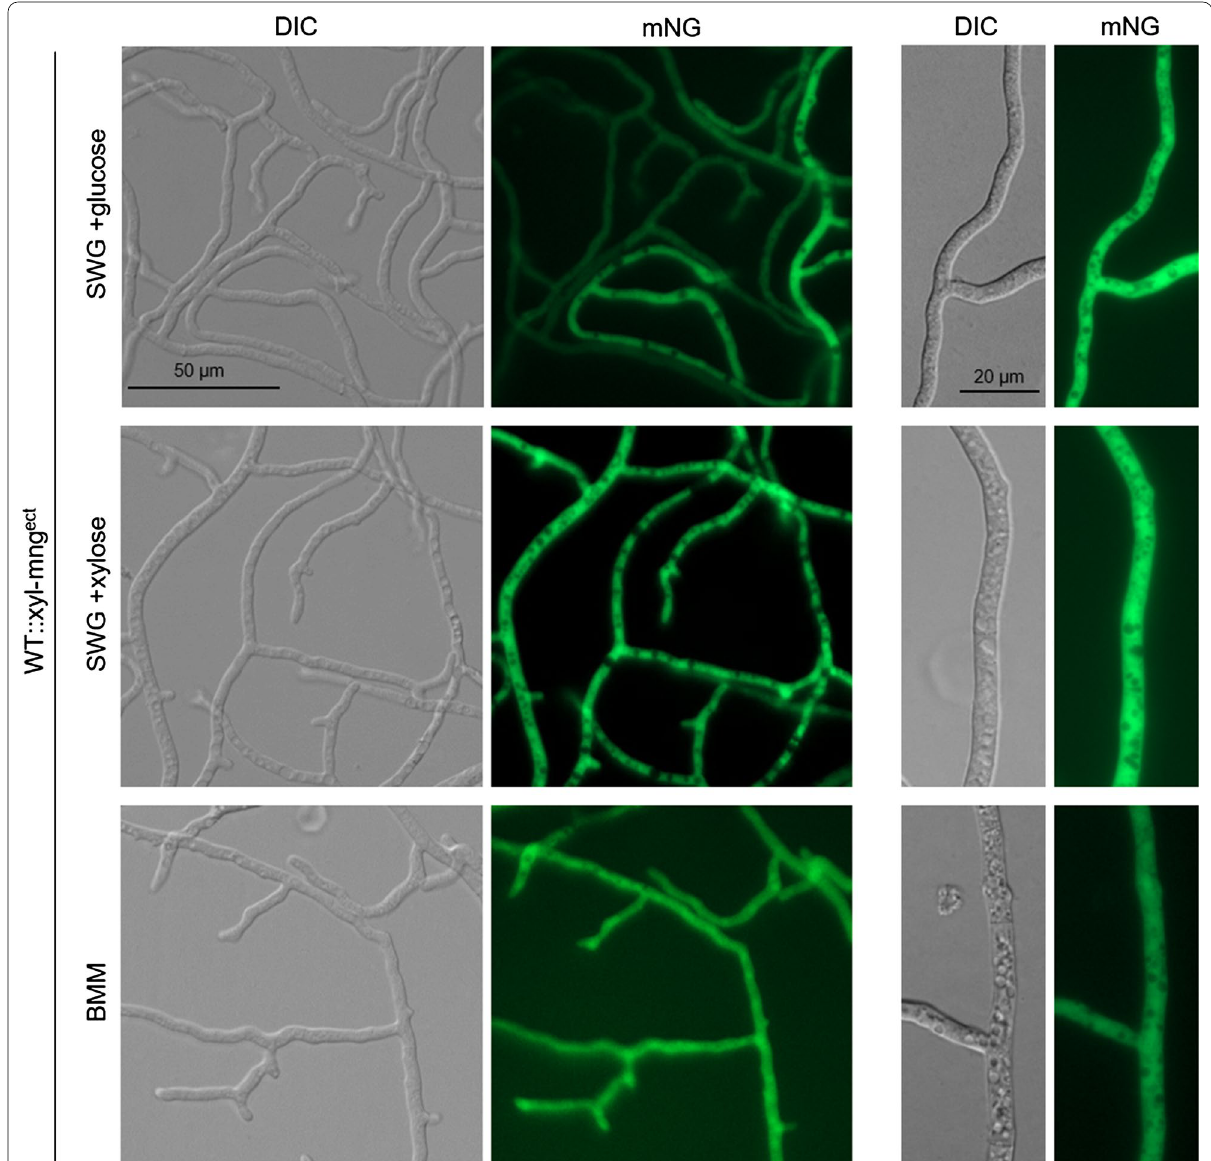
Fig. 2 Fluorescence microscopy to demonstrate mng expression under control of the Smxyl promoter, grown under non-inducing (SWG BMM) and inducing conditions (SWG xylose). The exposure time for image acquisition under both conditions was set to be the same. Scale bar, 50 + and 20